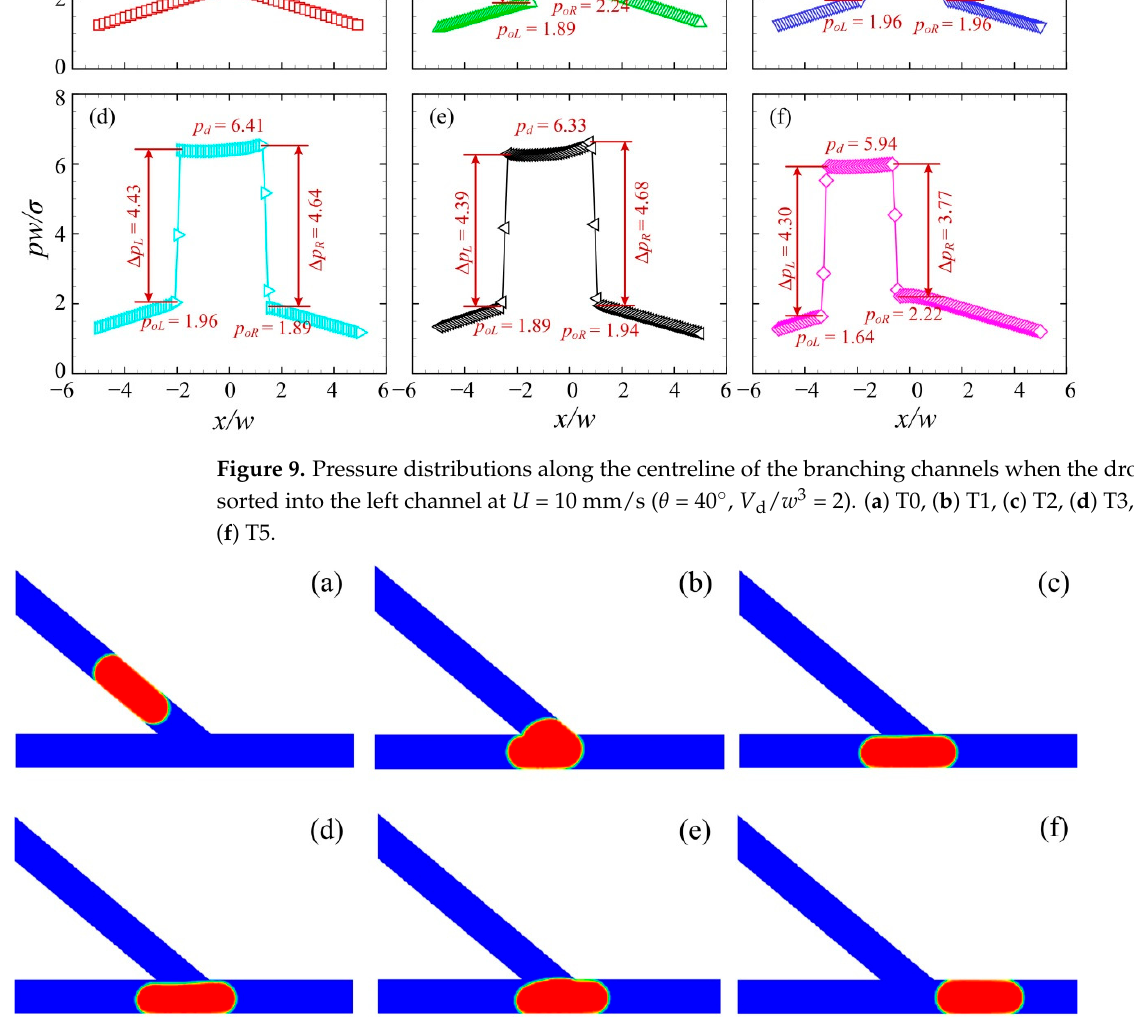
Figure 9. Pressure distributions along the centreline of the branching channels when the droplet is sorted into the left channel at U = 10 mm/s ( θ = 40°, V d / w 3 = 2). ( a ) T0, ( b ) T1, ( c ) T2, ( d ) T3, ( e ) T4, ( f ) T5.